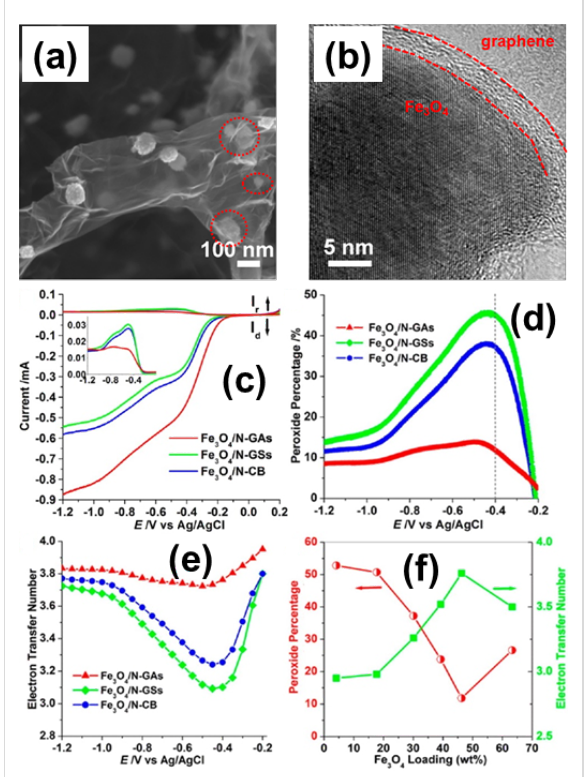
Figure 5: (a) SEM image of N-doped graphene aerogel (N-GA) sup- ported Fe3O4 NPs (Fe3O4/N-GA), where the red markings indicate Fe 3 O 4 NPs encapsulated in thin graphene layers. (b) HRTEM image of Fe 3 O 4 /N-GA, revealing an Fe 3 O 4 NP wrapped by graphene layers. (c) The rotating ring disk electrode (RRDE) test of the ORR on Fe 3 O 4 / N-GA, Fe 3 O 4 /N-doped GS (Fe 3 O 4 /N-GSs), Fe 3 O 4 /N-doped carbon black (Fe 3 O 4 /N-CB) in an O 2 -saturated 0.1 M KOH electrolyte at a rotation rate of 1600 rpm. The inset shows the ring current as a func- tion of the electrode potential. (d) Peroxide percentage and (e) elec- tron transfer number of Fe 3 O 4 /N-GAs, Fe 3 O 4 /N-GSs, and Fe 3 O 4 /N-CB as a function of the electrode potential. (f) Peroxide percentage and electron transfer number as a function of Fe 3 O 4 loading at − 0.4 V, as measured with RRDE in an O 2 -saturated 0.1 M KOH electrolyte. Reprinted (adapted) with permission from [147], copyright 2012 Amer- ican Chemical